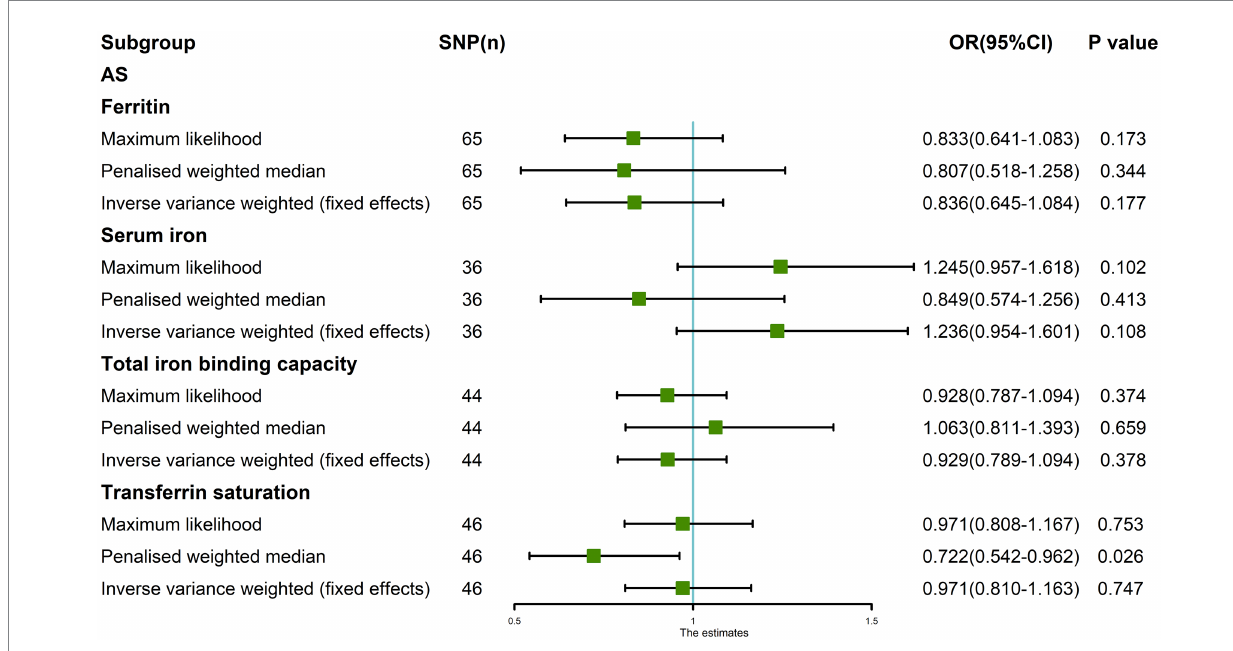
FIGURE 5 The MR analysis between four exposures (ferritin, serum iron, total iron binding capacity, transferrin saturation) and outcomes (ankylosing spondylitis). Three methods: Maximum likelihood, Penalized weighted median, and IVW (fixed effects).